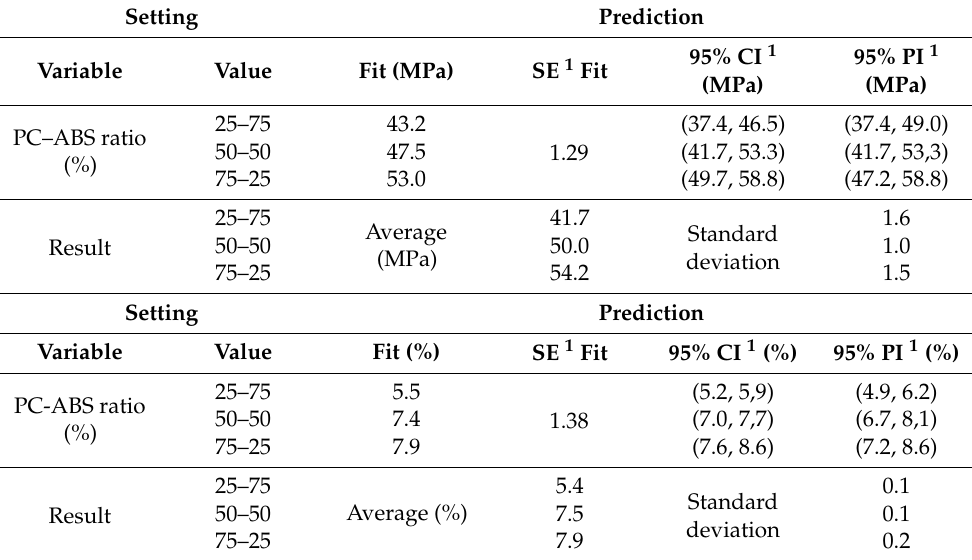
Table 3. Prediction and results for stress and